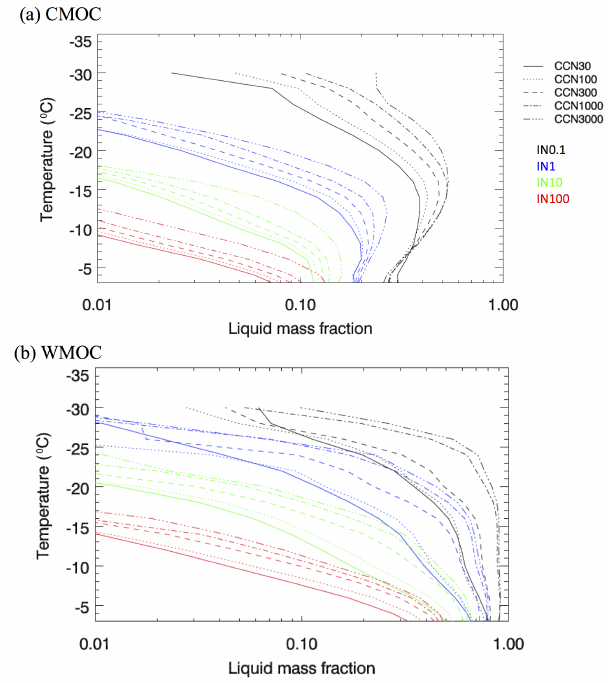
Figure 12. The liquid mass fraction vs. temperature for the (a) the CMOC and (b) the WMOC over the simulation time by excluding the first 2h. The liquid mass fraction is calculated for each tempera- ture bin of a 2K interval based on the total liquid water mixing ratio (droplets + raindrops) divided by the total condensate mixing ratio. The different line styles denote different CCN concentrations and different colors denote different INP